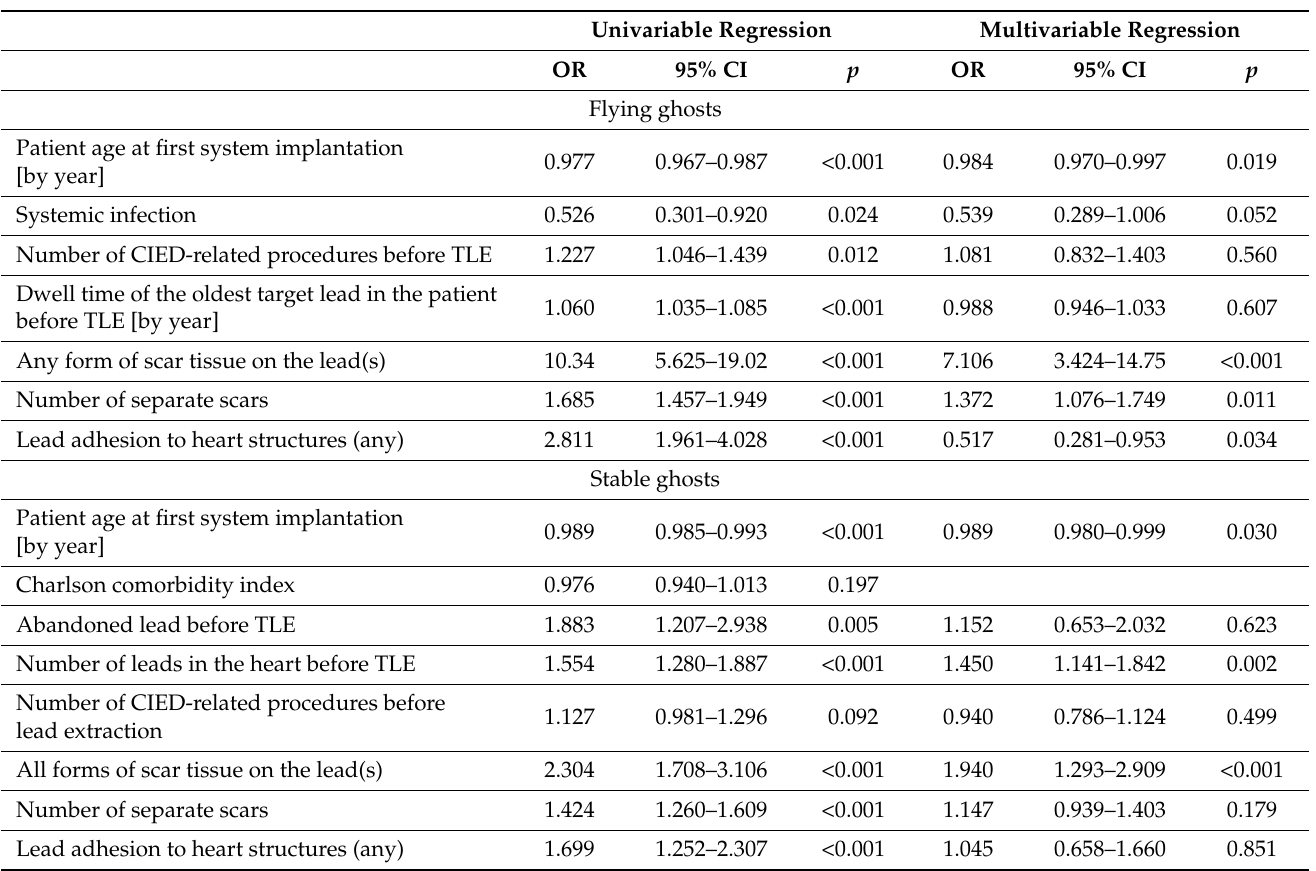
Table 2. Factors that influenced ghost (flying or stable) occurrence during and after TLE, results of uni- and multivariable regression analysis.